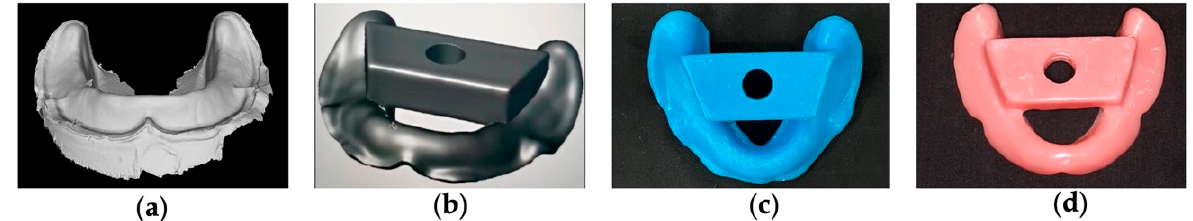
Figure 3. Elaboration of the prosthetic bases. ( a ) Digitalization of the final model; ( b ) Planning of the bases with Meshmixer ® software; ( c ) Prosthetic base printed on a Planmeca Creo ® C5 3D printer; ( d ) Prosthetic base in acrylic resin.